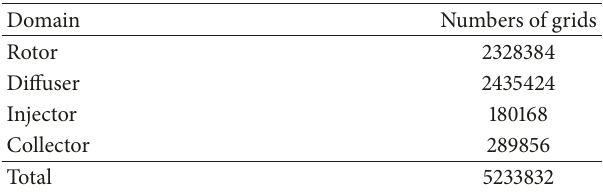
Table 2: Mesh densities of CFD